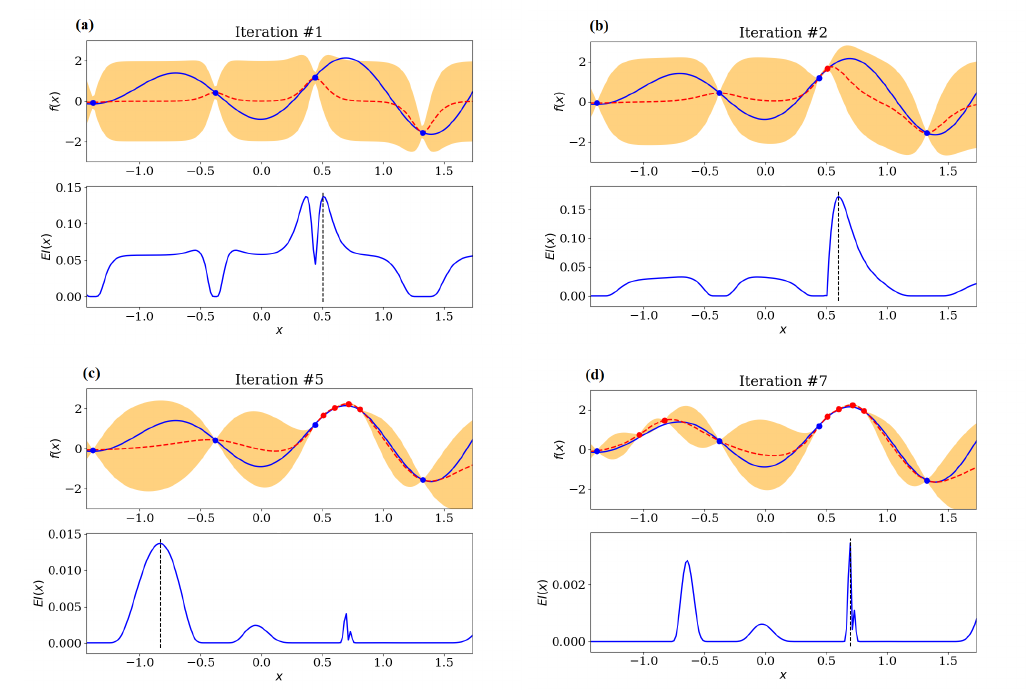
Figure A1. Sequence of Bayesian Optimization iterations for maximizing f ( x ) . ( a ) Iteration #1 : Prediction based on initial DOE of 4 points. ( b ) Iteration #2. ( c ) Iteration #5. ( d ) Iteration #7. Filled blue circles indicate initial DOE. Filled red circles denote points selected in optimization